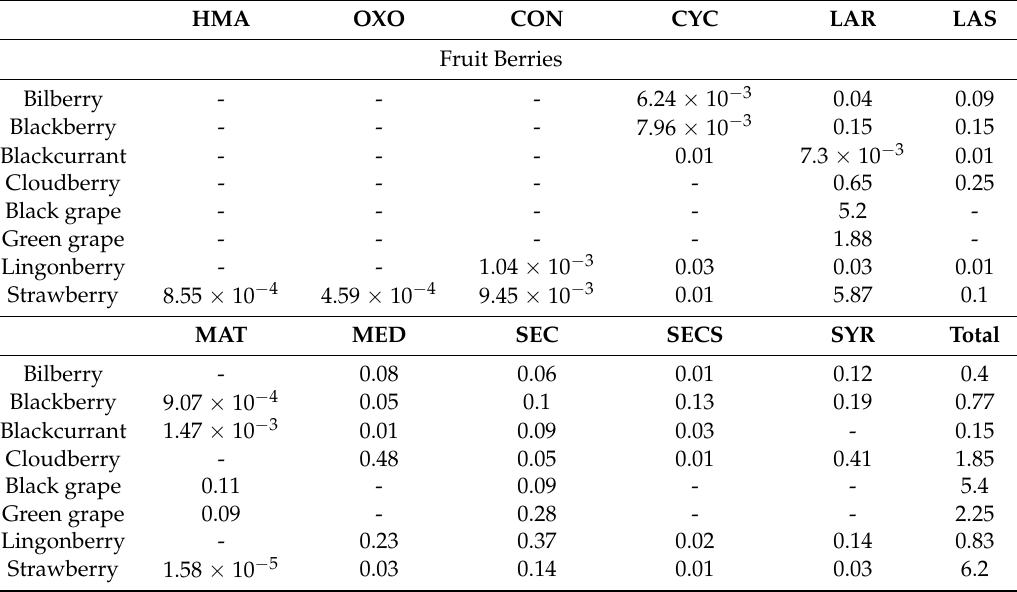
Table 5. Lignan contents of fruits berries (mg/100g food) [18].